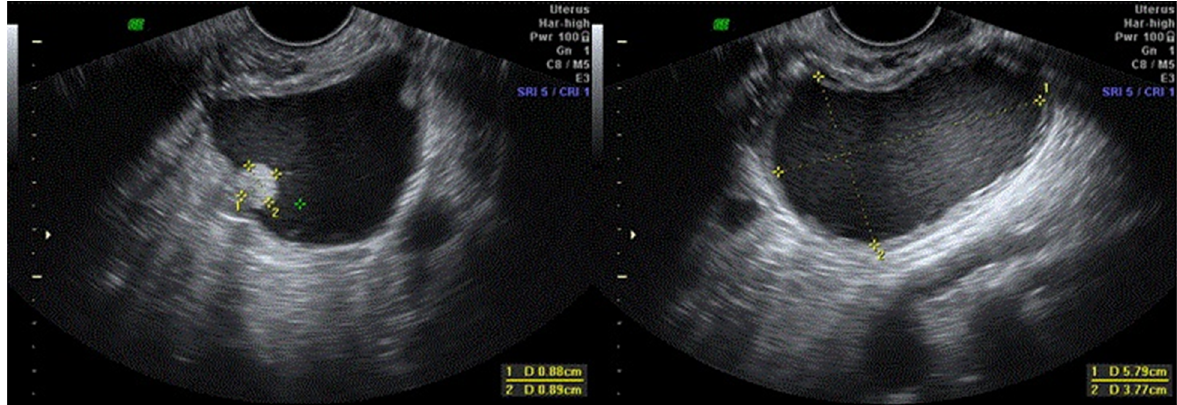
Figure 3. Case number 3; 37 years old woman, presented with dysmenorrhea, infertility (13 cycles of IVF), 0 parity. On TVUS unilocular solid cyst, hystological result was a borderline serous tumor.